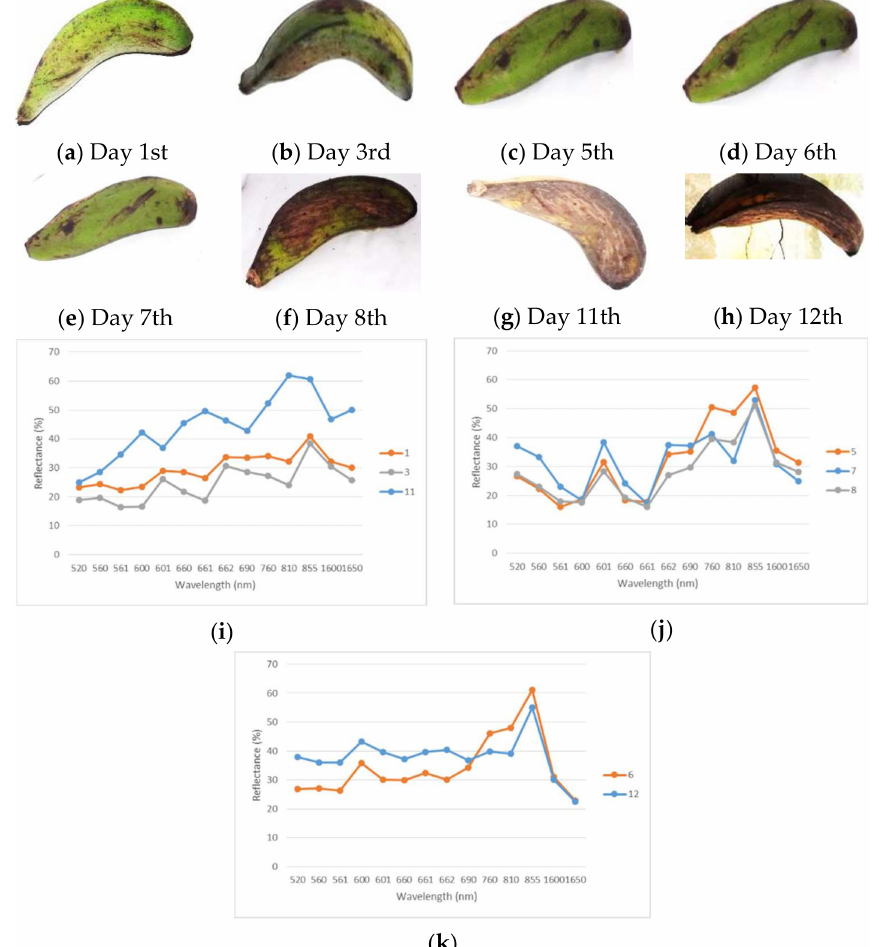
Figure 8. The ripening process of the Rajabulu in the 1st, 3rd, 5th, 6th, 7th, 8th, 11th, and 12th day ( a – h ) and classification of spectral reflectance, based on its repetition and similar shape ( i – k